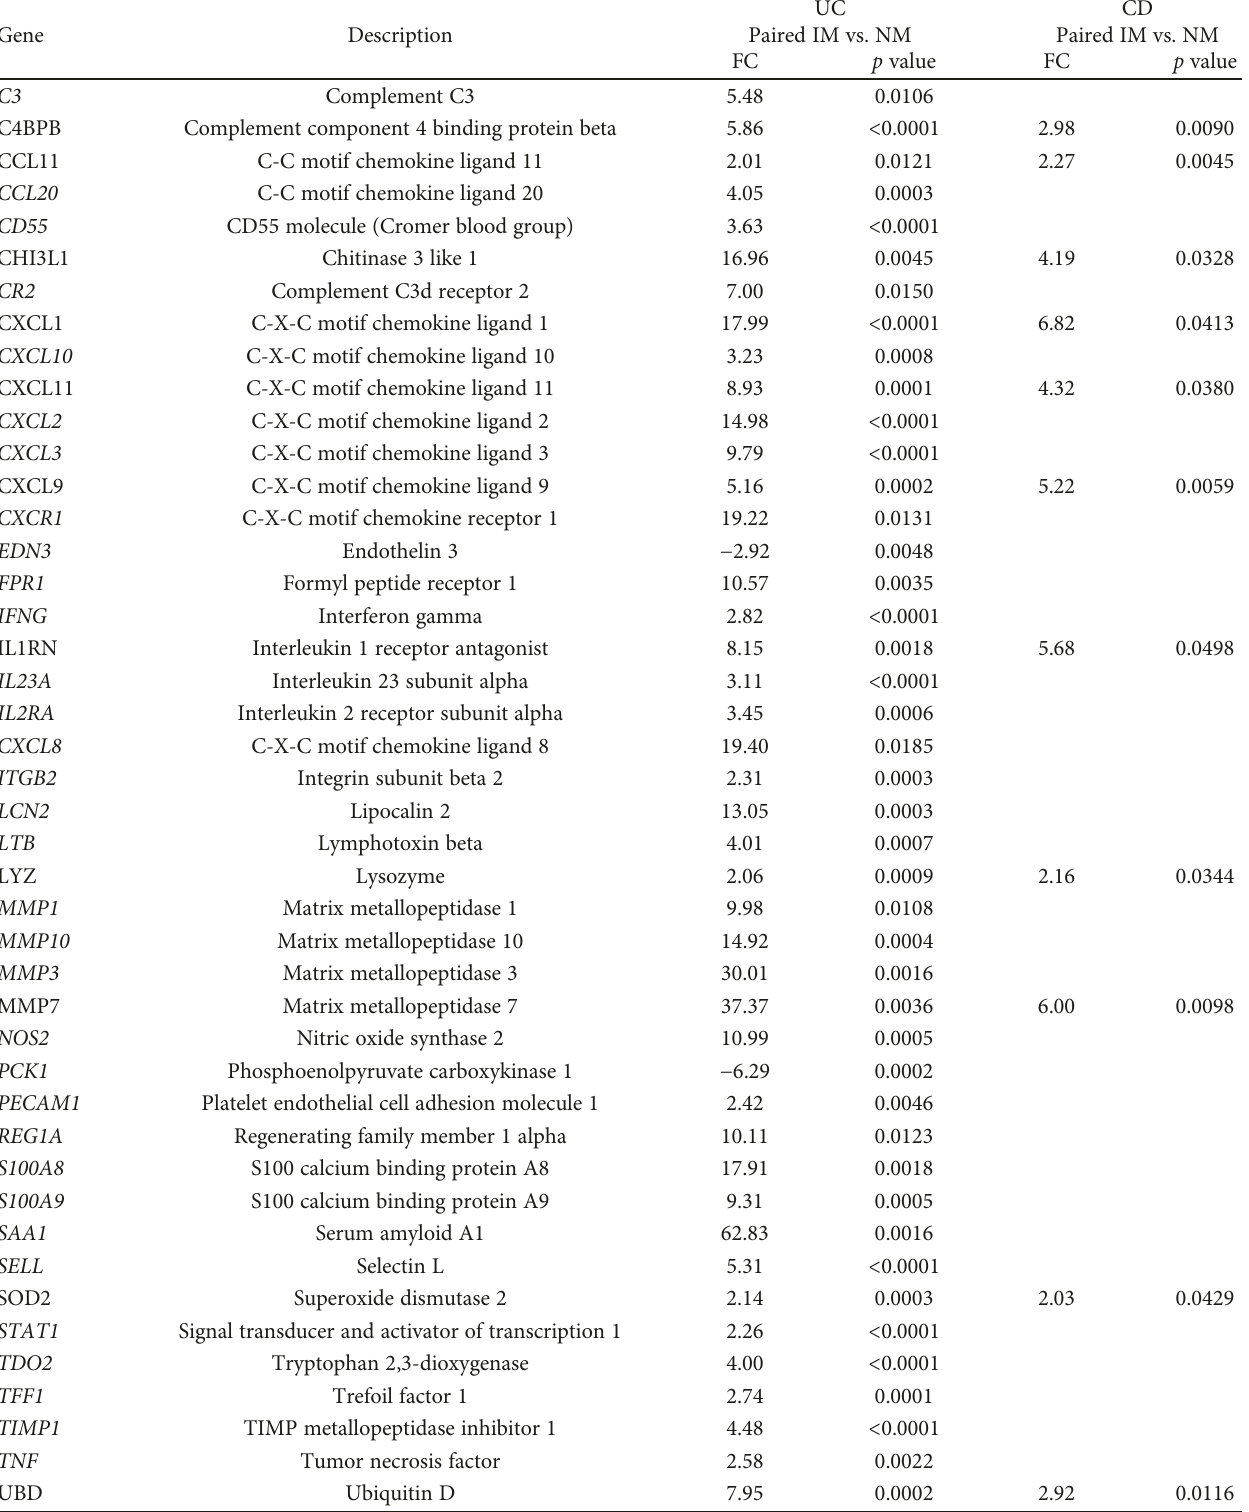
Table 2: The table shows the transcripts that di ff ered by > 2.0 fold with p < 0 05 in in fl amed mucosa (IM) vs. nonin fl amed mucosa (NM) in UC and CD patients. Genes are arranged by alphabetic order. Italic fonts indicate genes di ff erentially expressed only in IM from UC.